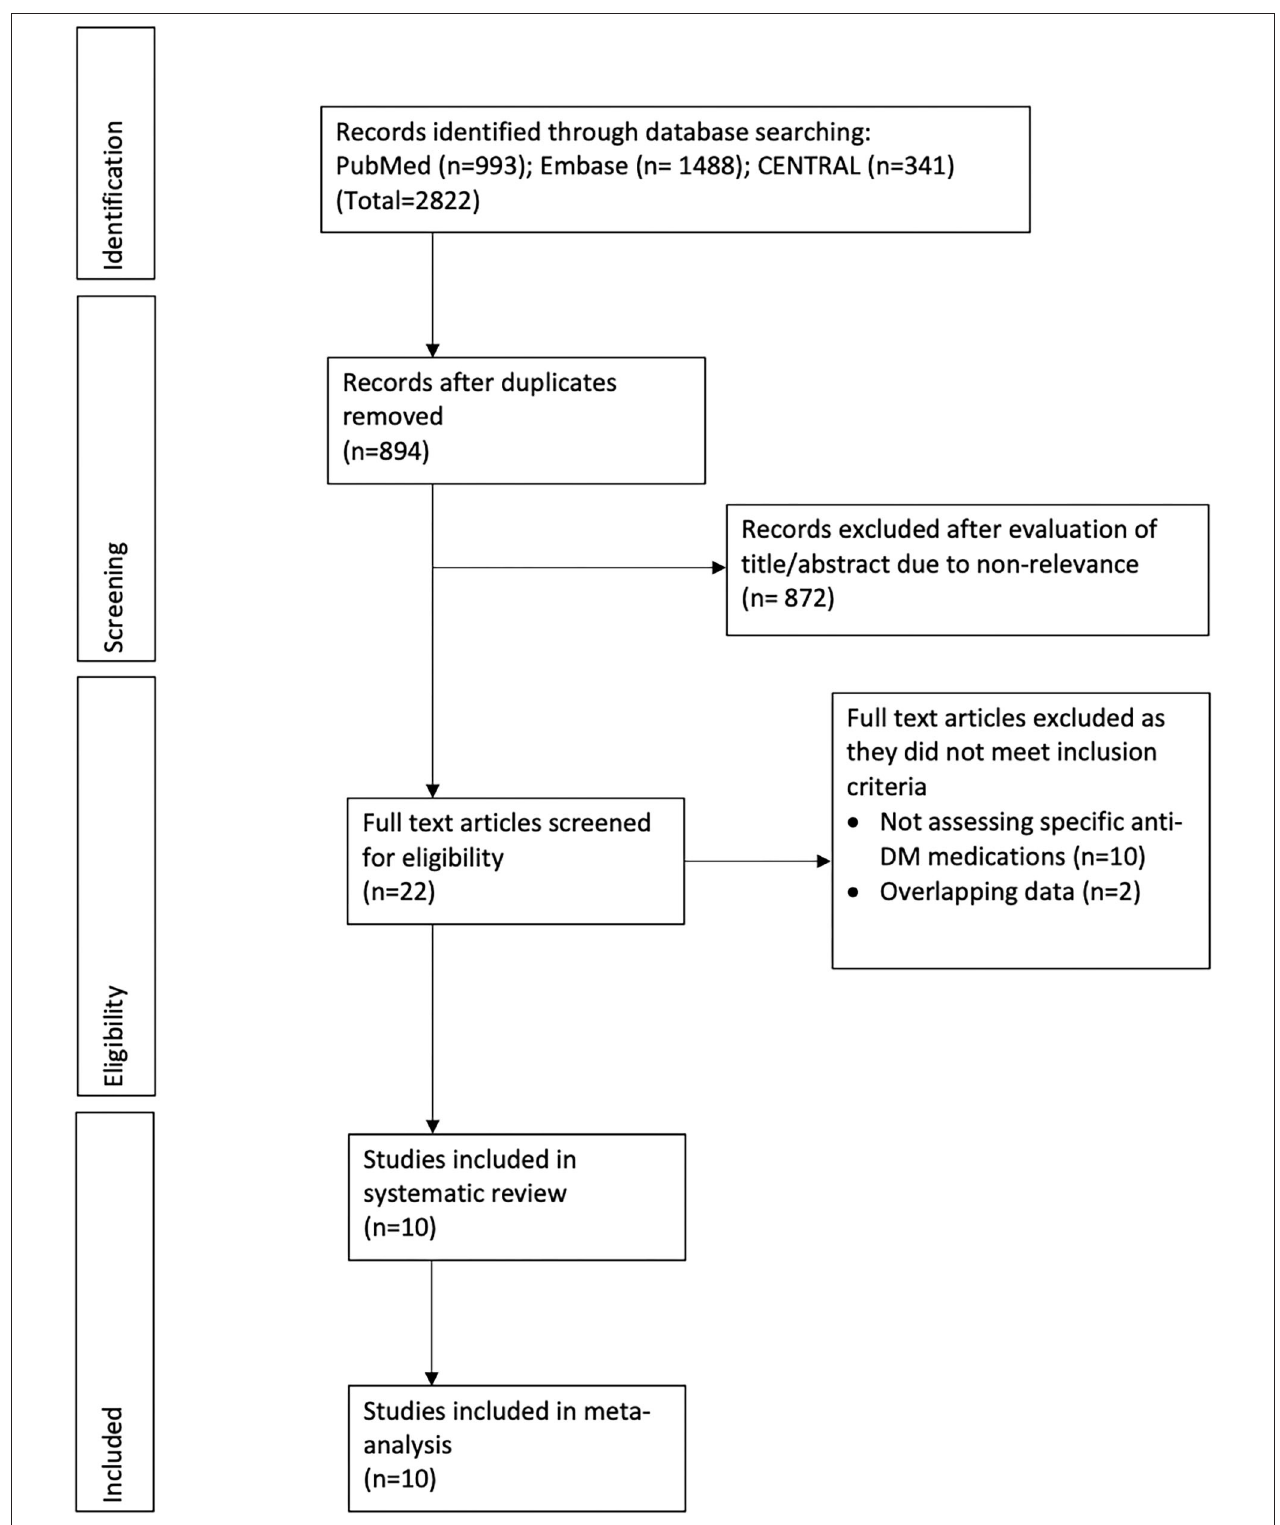
FIGURE 1 | Study flow